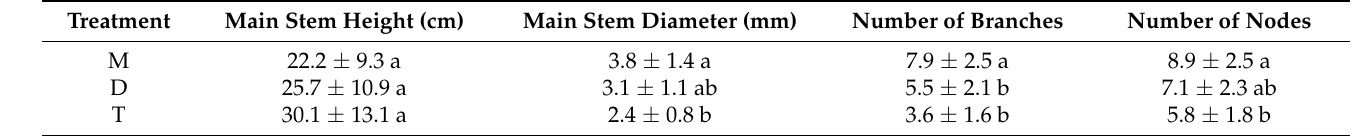
Table 3. Effect of seeding pattern on plant growth parameters of peanut.